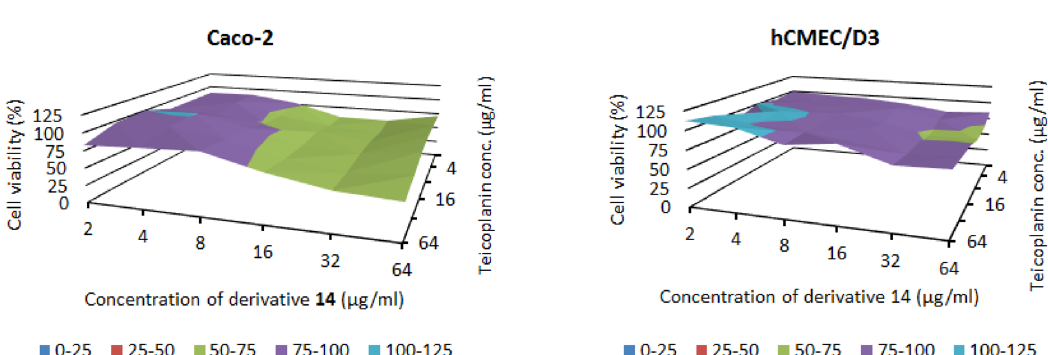
Figure 10. Cytotoxic effect of teicoplanin in combination with compound 14 towards Caco-2 and hCMEC/D3 cells, measured by checkerboard method.